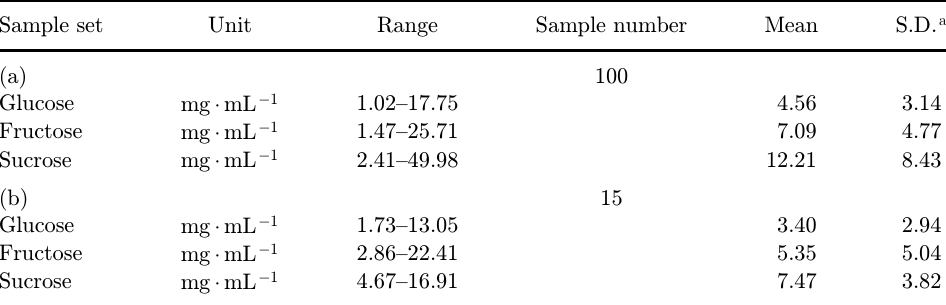
Table 3. Concentration ranges of the samples in the training set (a) and external testing set (b).